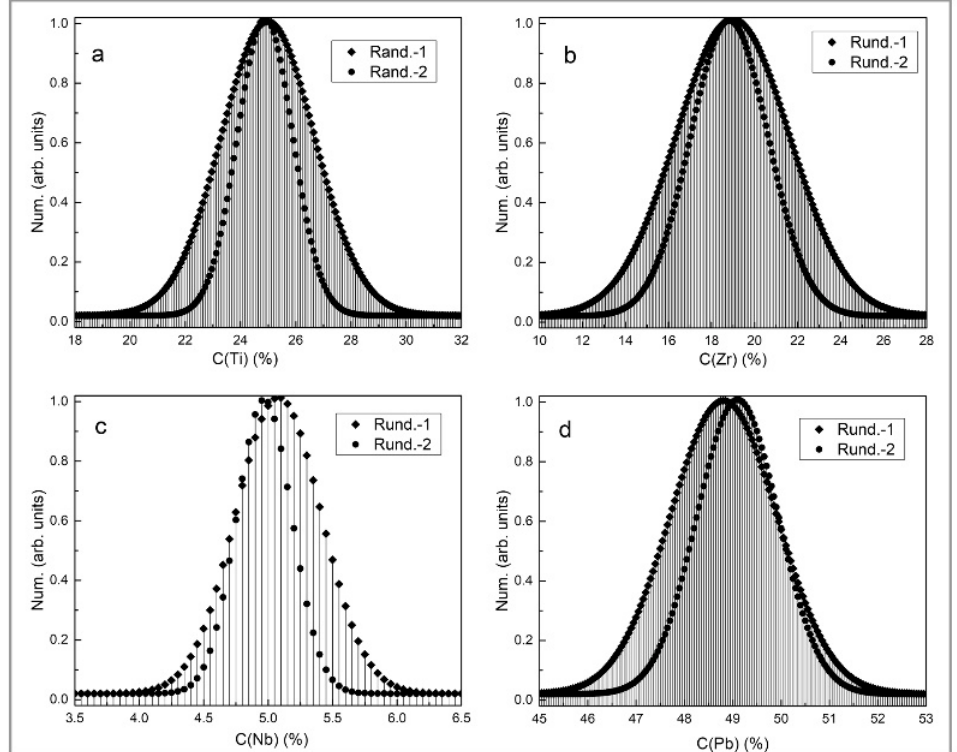
Figure 8. Results of the statistical analysis and the distribution of concentrations of the basic chemical elements obtained for a sample (CCT3) prepared by the standard technology at a stage just before the sintering process.